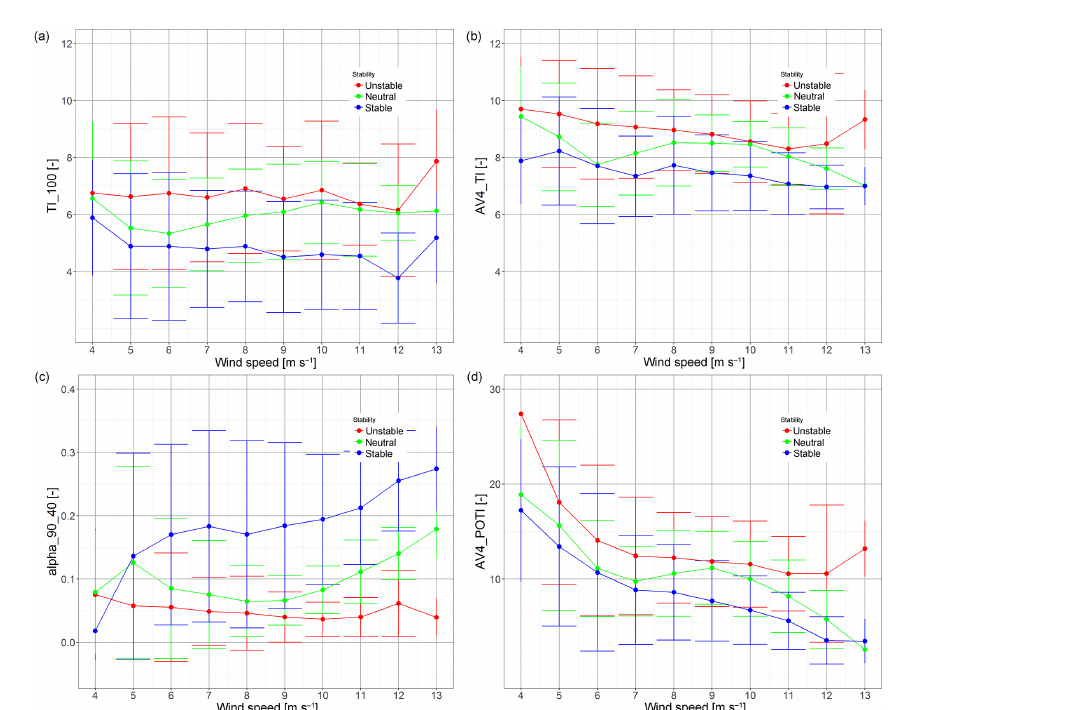
Figure 7. (a) Turbulence intensity at FINO1, (b) turbulence intensity at AV4, (c) power law coefficient for shear at FINO1 heights of 40 and 90m and (d) standard deviation of the power divided by the average power for free-flow conditions at AV4. All four measurements are provided as a function of the wind speed for three stability classes based on ζ = 33 L